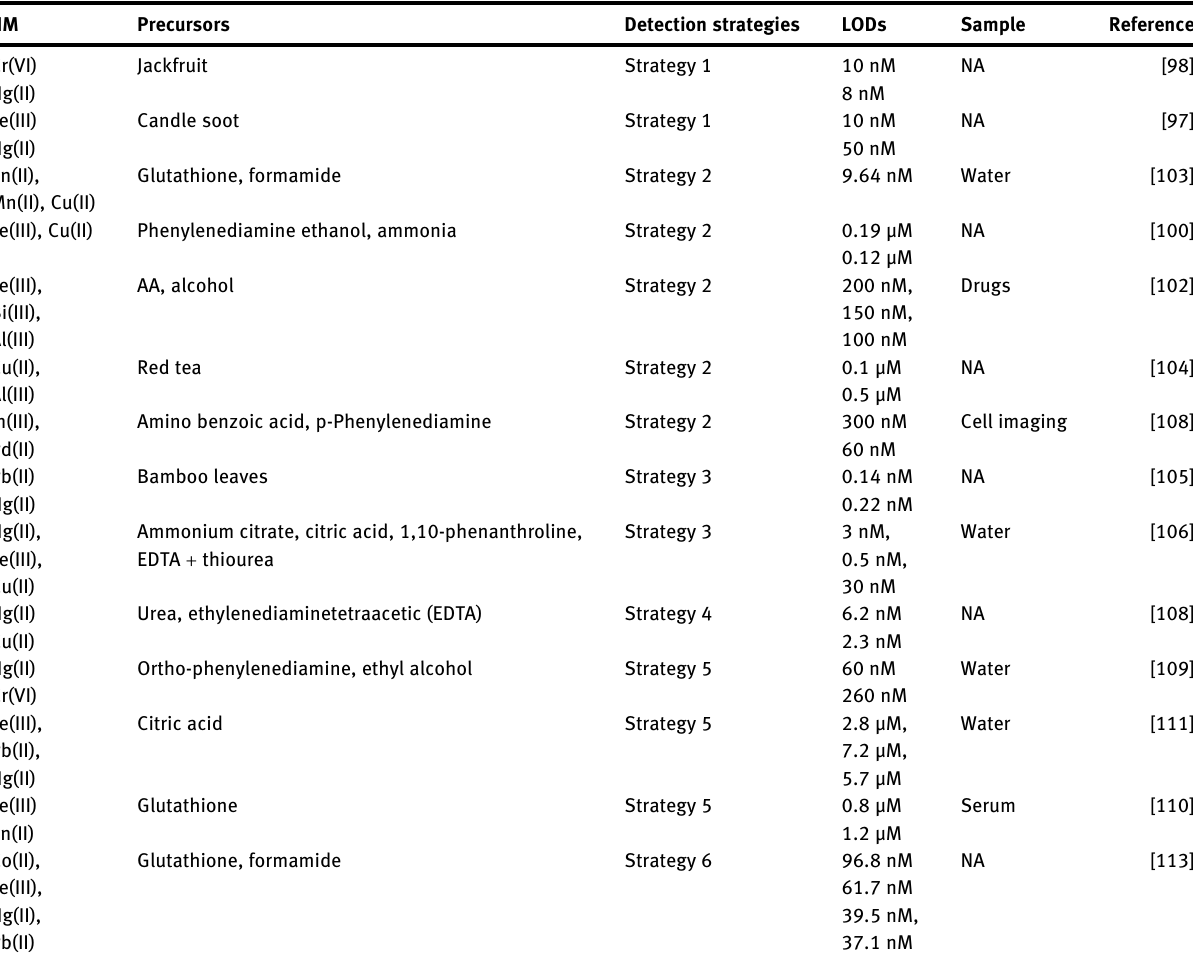
Table  : Summary of CD-based sensors for multi-HMs detection.